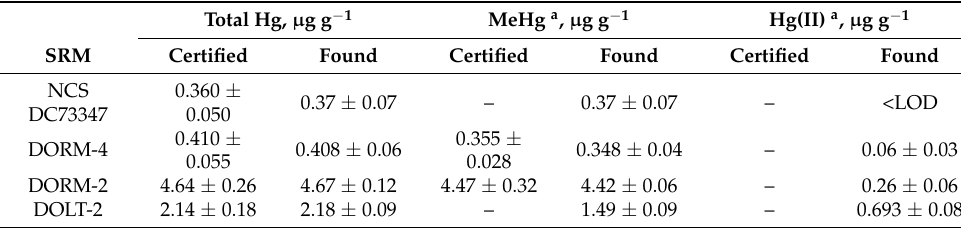
Table 2. Total mercury, Hg(II) and MeHg contents in hair and fish reference materials